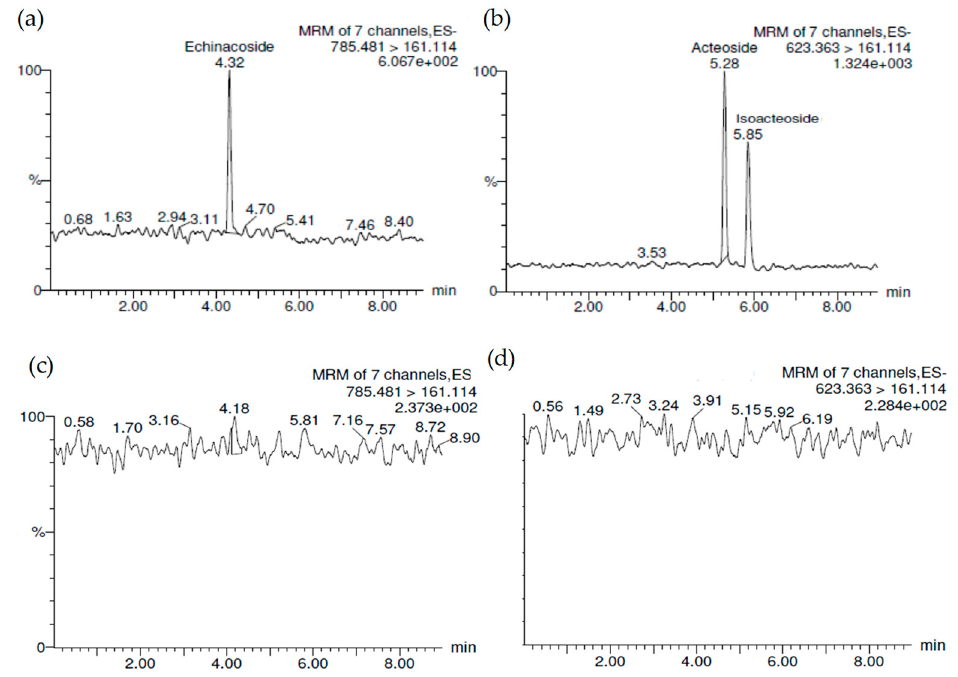
Figure 2. The UPLC/MS/MS chromatograms of ( a ) 1 ( t R = 4.32 min) and ( b ) 2 ( t R = 5.28 min) and 3 ( t R = 5.85 min). ( c , d ) Blank brain tissue. The phenylethanoid glycosides ( 1 – 3 ) were respectively spiked with rat brain tissue homogenate.